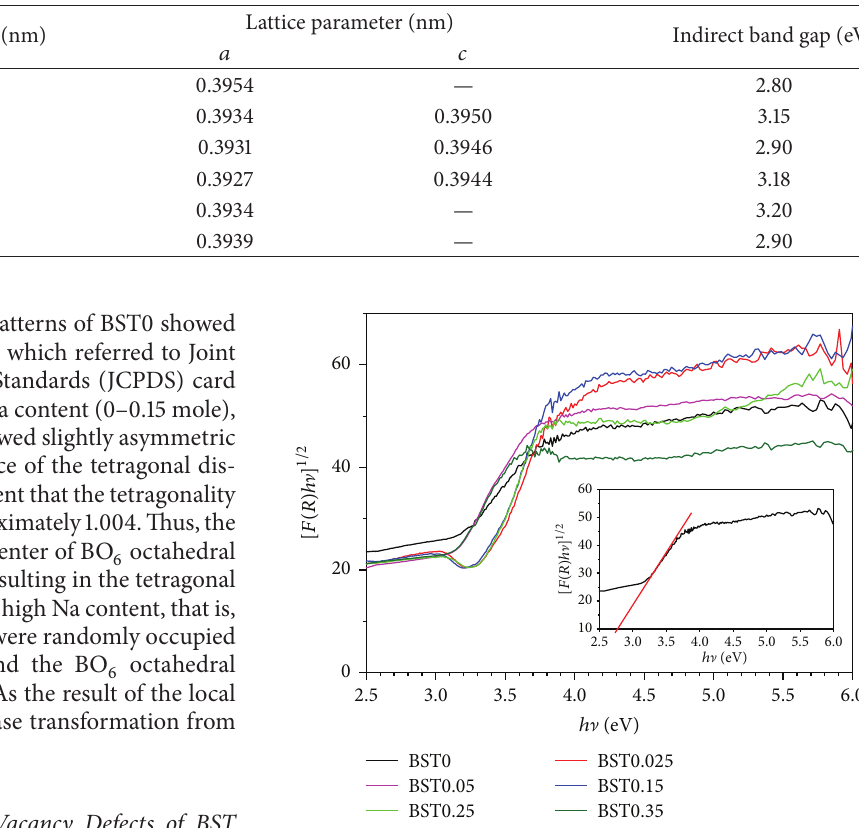
Figure 3: The UV-vis spectra of BST powders with various